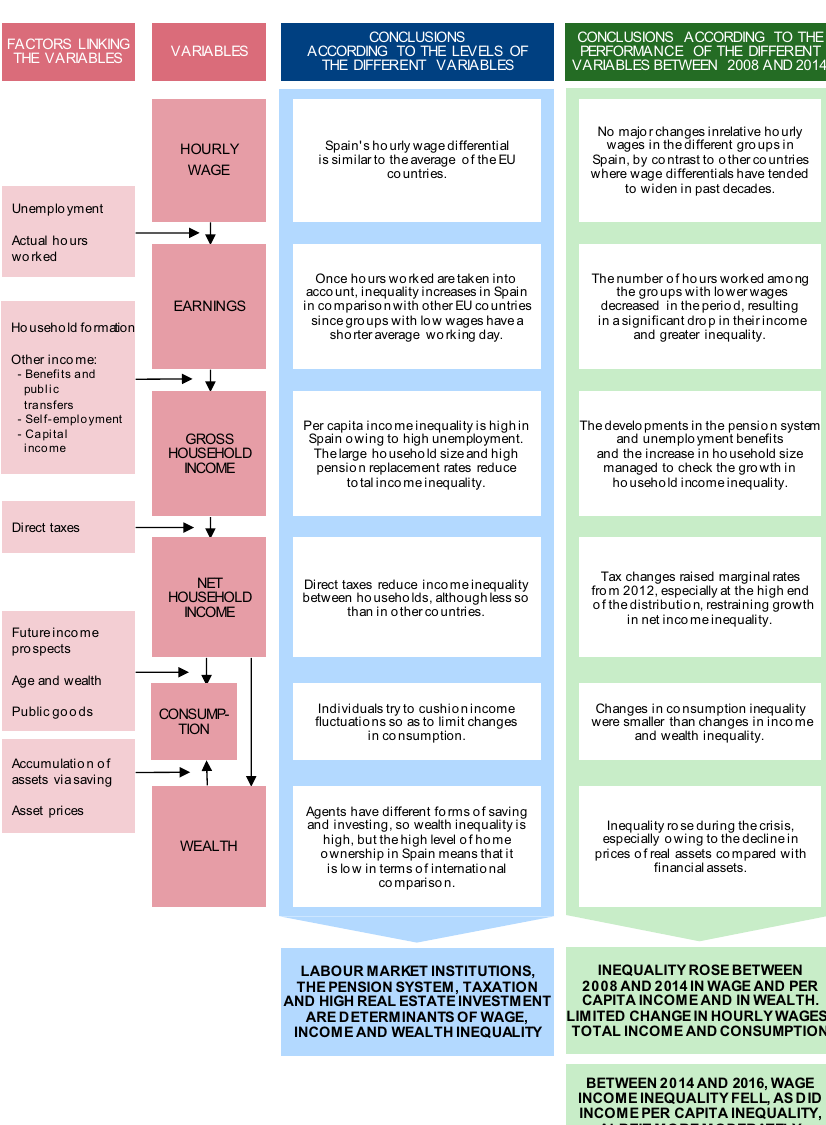
Fig. 15 Income,consumptionandwealthinequality:relationshipbetweenthevariablesandmainconclusions drawn from their recent performance. Source : Banco de España